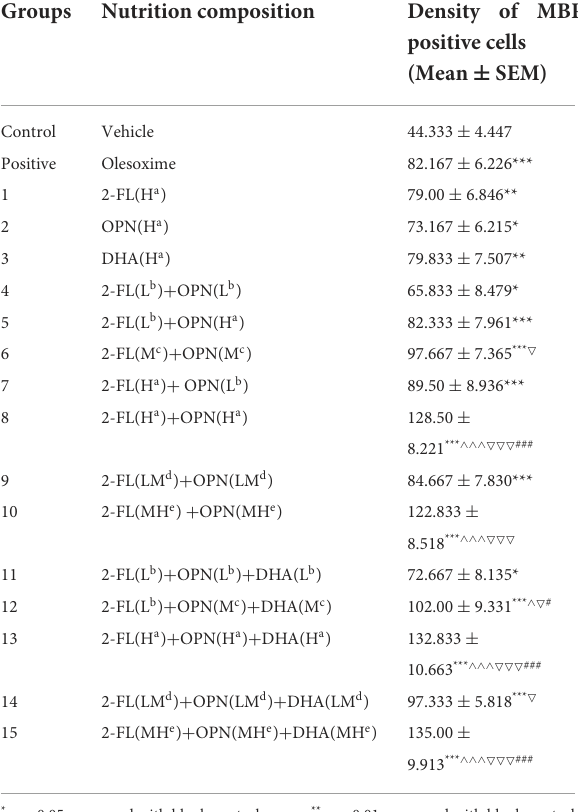
TABLE 4 Effects of different nutritional compositions containing 2’-FL, OPN and/or DHA on the number of MBP positive cells.